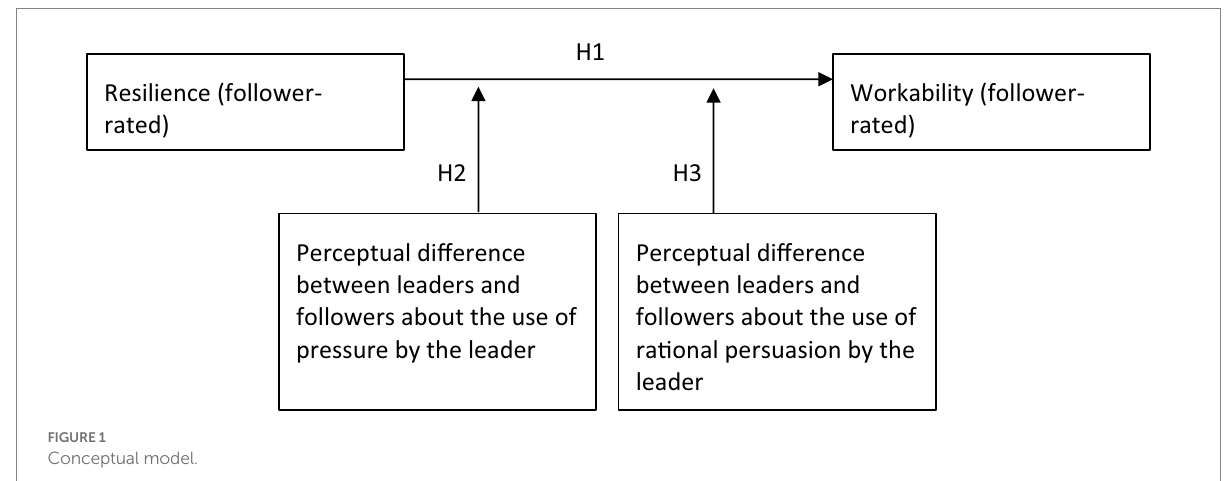
FIGURE 1 Conceptual